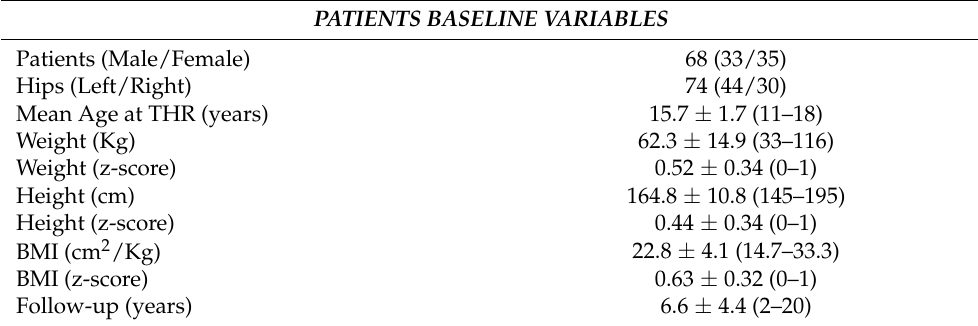
Table 2. Patient characteristics and baseline variables. All results are expressed as crude numbers for dichotomous variables and as mean ± Standard Deviation for continue variables.